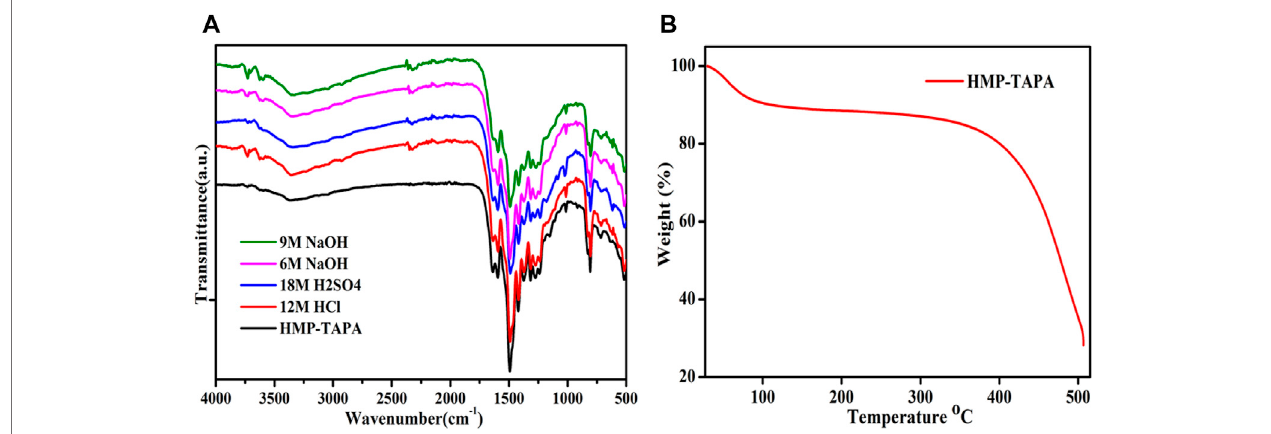
FIGURE 5 | (A) Stability studies for HMP-TAPA analyzed using FTIR spectra over a period of 7 days in different solvents. (B) TGA plot for HMP-TAPA.